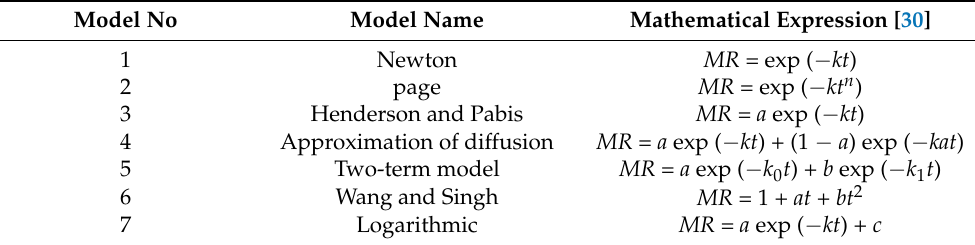
Table 1. Seven drying models for wet porous media. Model